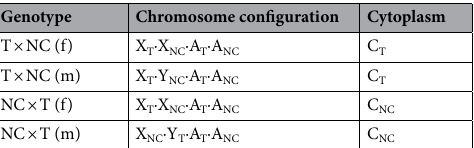
Table 3. Chromosome configuration and cytoplasm in reciprocal R. hastatulus hybrids. X T , Y T Texas sex chromosomes, X